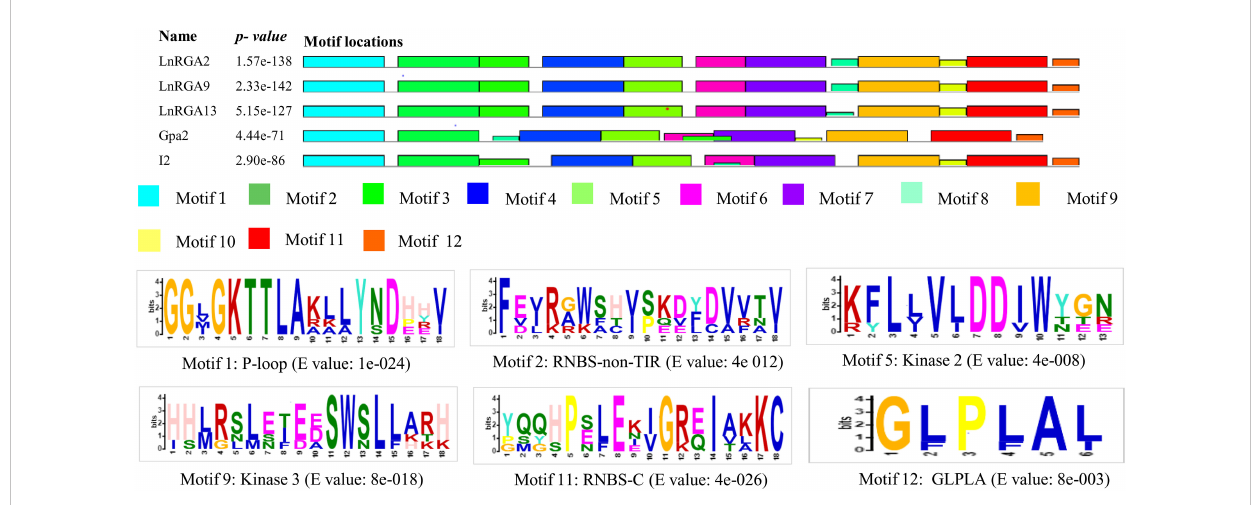
FIGURE 9 Diagrammatic representation of conserved motif of non-TIR RGAs within NBS domain along with R genes Gpa2 and I2. The solid black line represents each RGA, and their lengths with motifs are represented in colored boxes. Sequence logo of six conserved motifs along with their E value is given below.